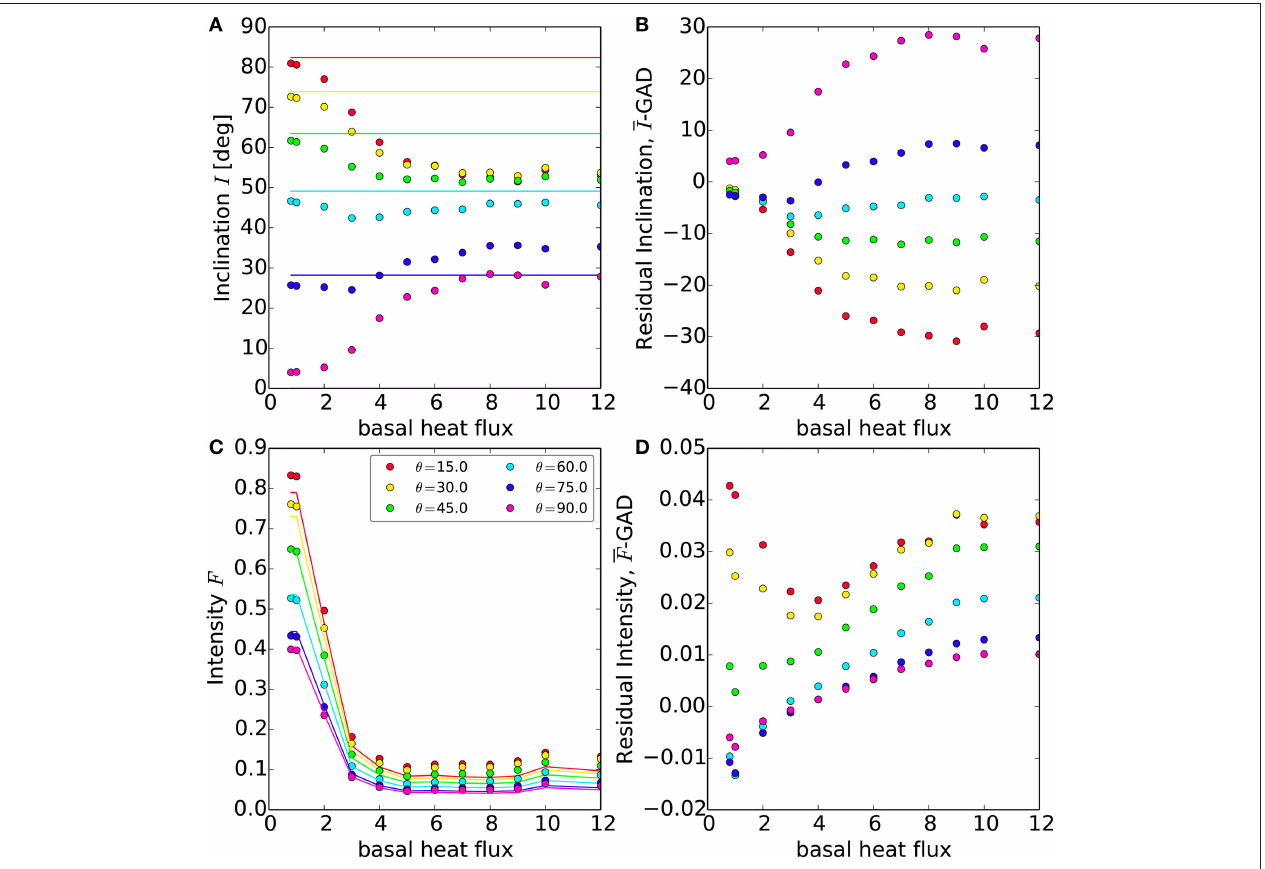
FIGURE 7 | Comparison of synthetic observations with τ = 500 kyr. (A) Observed running average inclination I (circles) from (9), colors correspond to site co-latitude θ k (see legend), solid lines are the GAD inclination, computed from (17) with θ k . (B) Residual between observed and GAD inclination. (C) Observed running average magnetic intensity F (circles) from (7), colors correspond to site co-latitude θ k (see legend), and solid lines are the GAD intensities. (D) Residual between observed and GAD